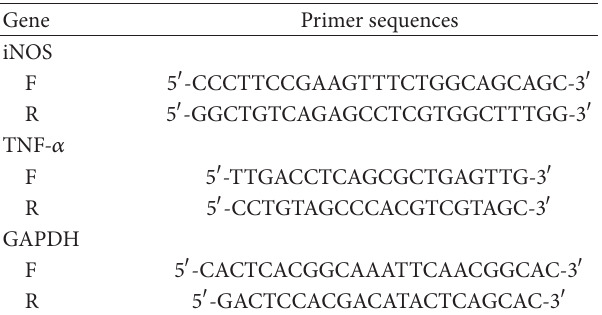
Table 1: Sequences of primers used in real-time PCR